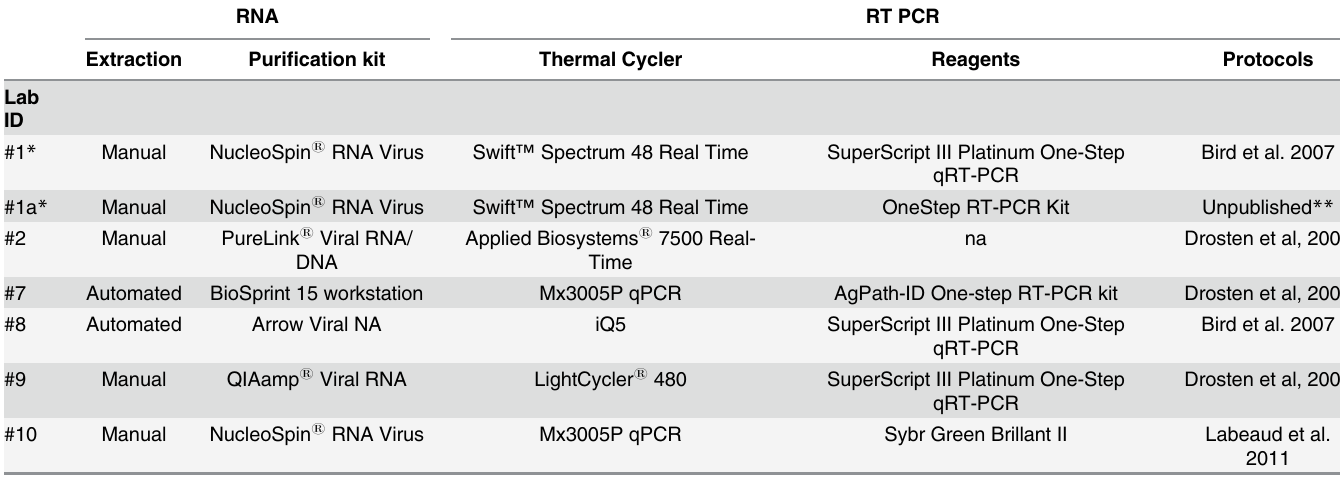
Table 3. EQA for RVFV virus genome detection, RNA extraction and RT PCR instruments and methods.